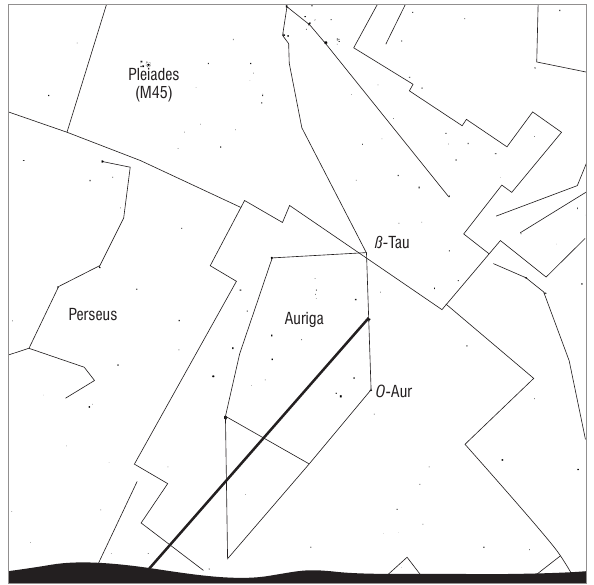
Figure 2: View of the night sky, as observed by the amateur astronomer at Mabelingwe Caravan Park, showing the approximate path